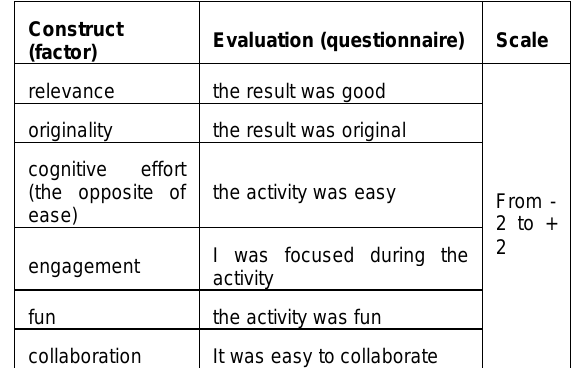
Figure 3a. Location of the domestic environment (home), indicated with the letter B